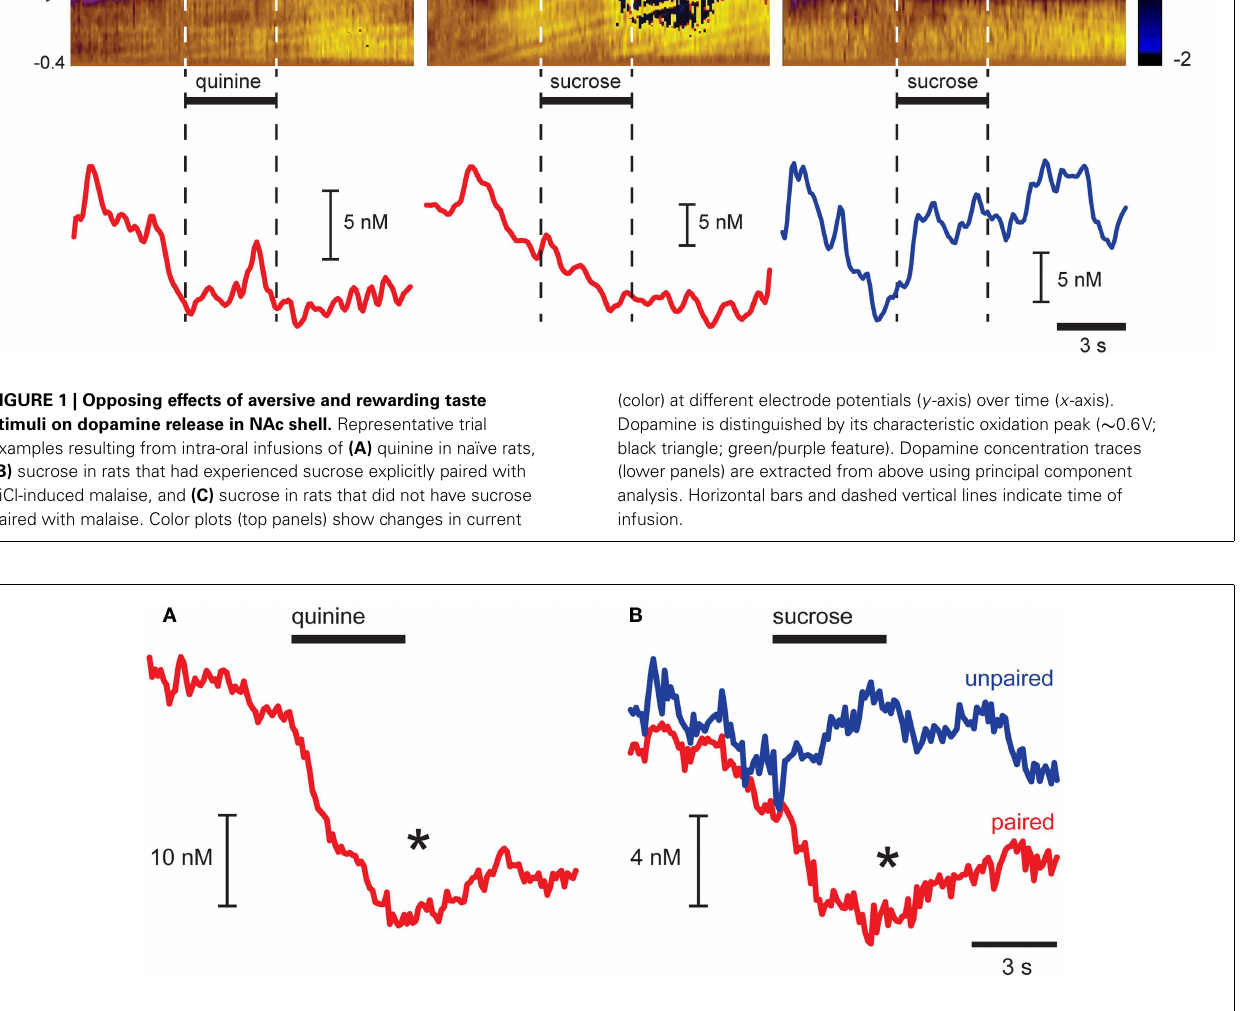
FIGURE 2 |Aversive stimuli suppress dopamine release in NAc shell. Averaged dopamine concentration traces showing suppression of dopamine release after quinine (A) and sucrose